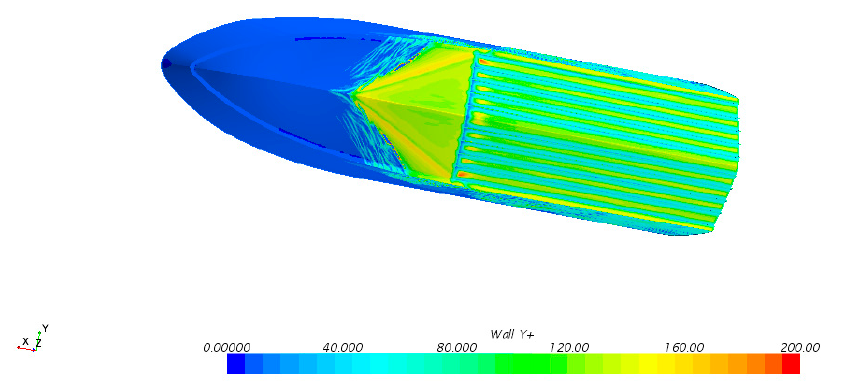
Figure 9. Wall y+ at full speed.